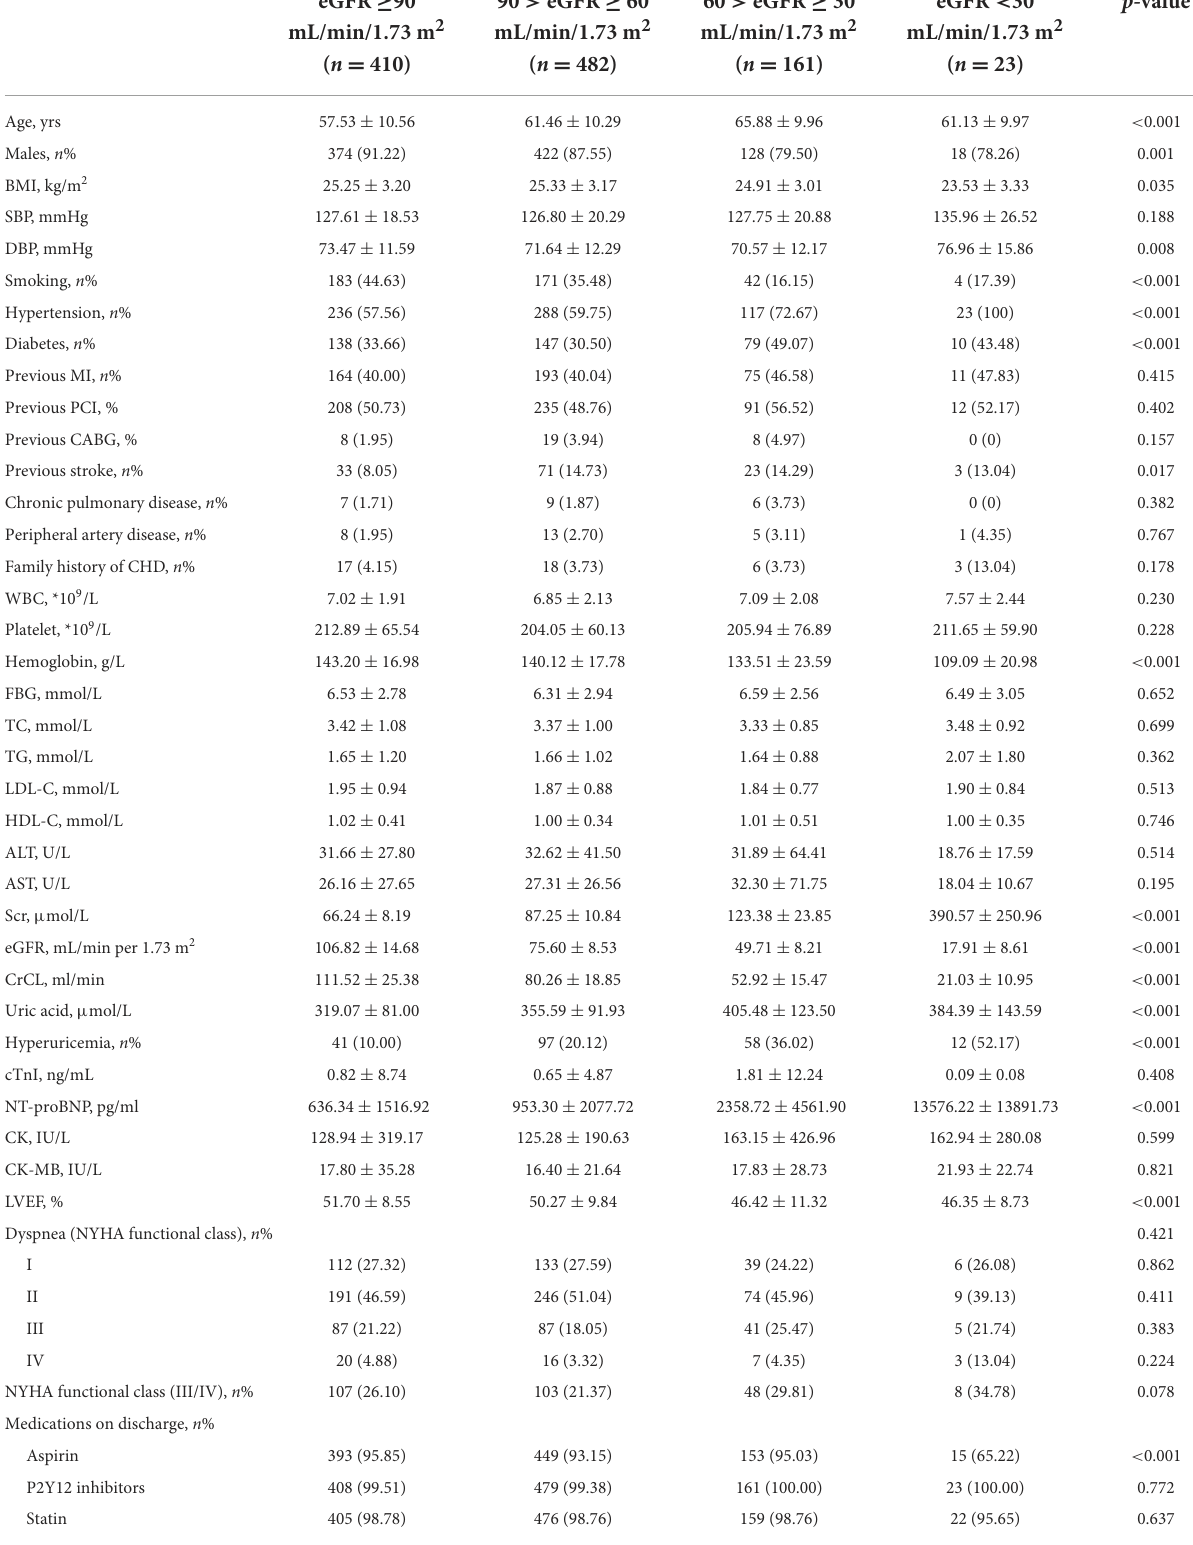
TABLE 1 Baseline